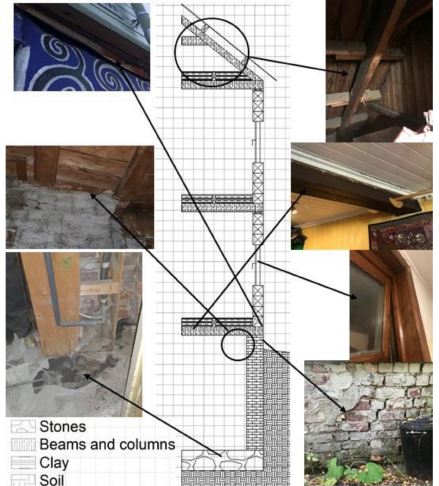
Figure 9. Illustrated section of the building in Strandveien 19 (Sekkal, 2019).